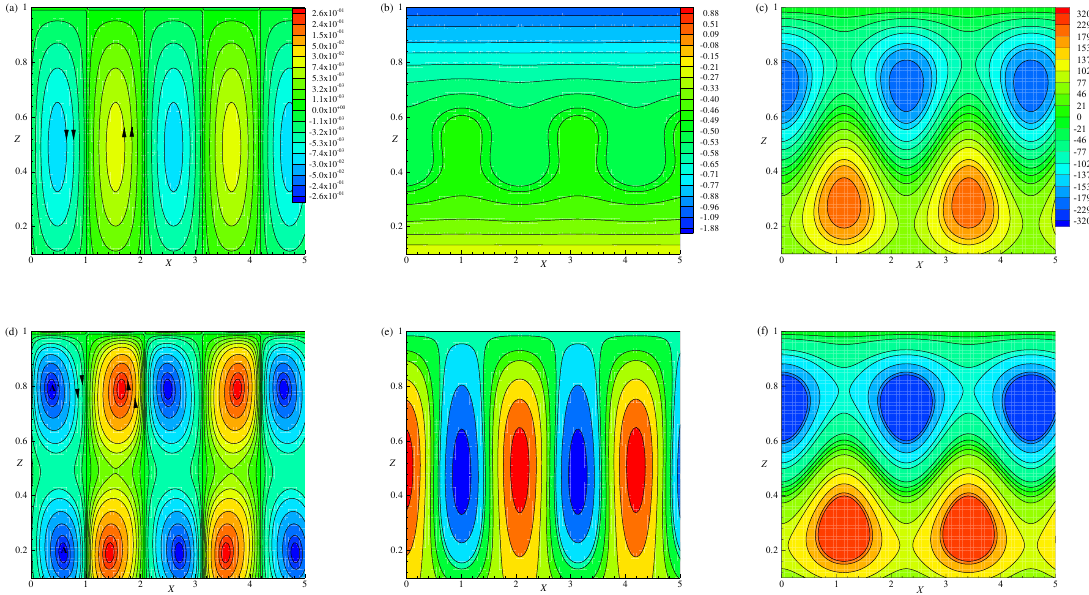
result suggests that the heat transfer is enhanced as time increases for the fixed values of the physical parameters. Figure 11c is a plot of the isoconcentration lines for t = 1.1 and the absolute maximum and minimum values of isoconcentrations are 203.197 and − 204.238, respectively. Figure 11f plots the isoconcentration lines for the same values of physical parameters as those defined in Figure 11c and for t = 1.6. The absolute maximum and minimum values of isoconcentrations are 290.001 and − 291.049, respectively. As t increases from 0.1 to 1.6, the convective mass transport of the fluid increases. Finally, the boundary layer thickness of both the temperature and concentration fields decrease as time increases.